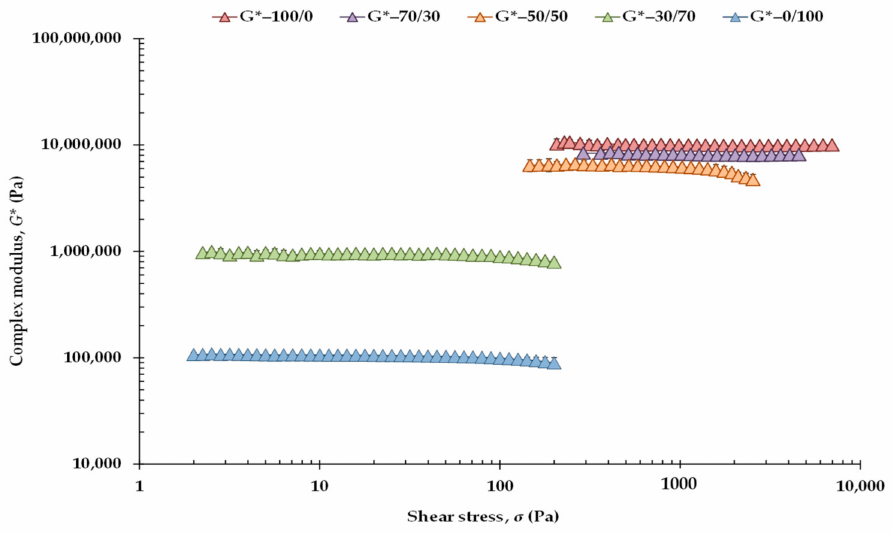
Figure 1. Complex modulus ( G *) as a function of the applied shear stress at 1 Hz and at 20 ◦ C for the CB/OG blends. Shear stress ranged from 2 to 10,000 Pa depending on the CB/OG blend